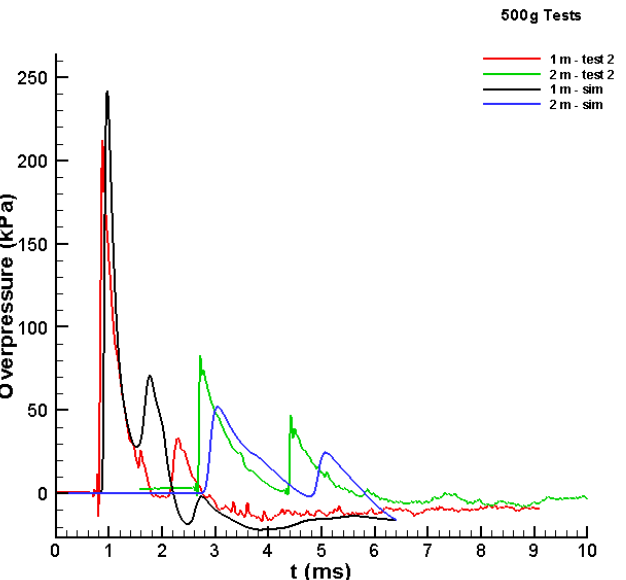
Figure 9. Comparison between test data and simulated values for the pressure versus time history for the 500 g Al/air cloud with a 63 cm diameter.